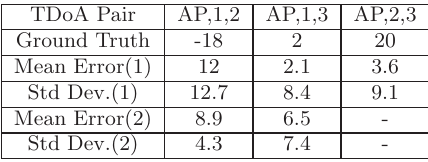
Table 7: Indoor TDoA comparison results in inches